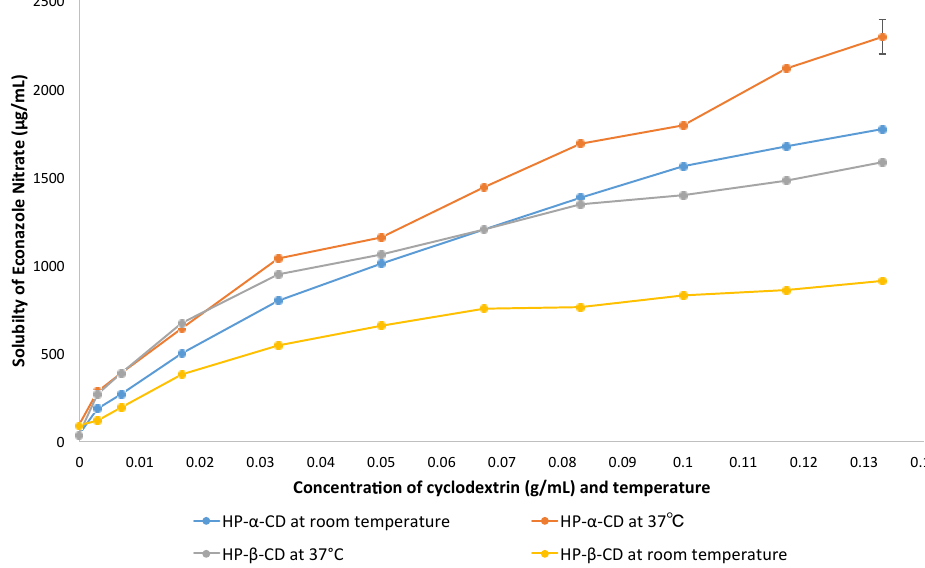
Figure 2. Solubility of econazole nitrate (g/mL) in the presence of sub ‐ saturated levels of HP ‐α‐ CD and HP ‐β‐ CD in PBS at room temperature and 37 °C. Table 1. Solubility of econazole with increasing amounts of HP ‐α‐ CD or HP ‐β‐ CD in PBS at room temperature and 37 °C, and molar ratios of cyclodextrin–econazole in saturated PBS solution. MW centration by 10 3 /MW).